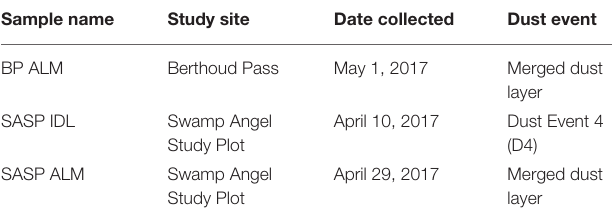
TABLE 1 | Samples collected in spring 2017 from Berthoud Pass (near Fraser, Colorado), and the Swamp Angel Study Plot in Senator Beck